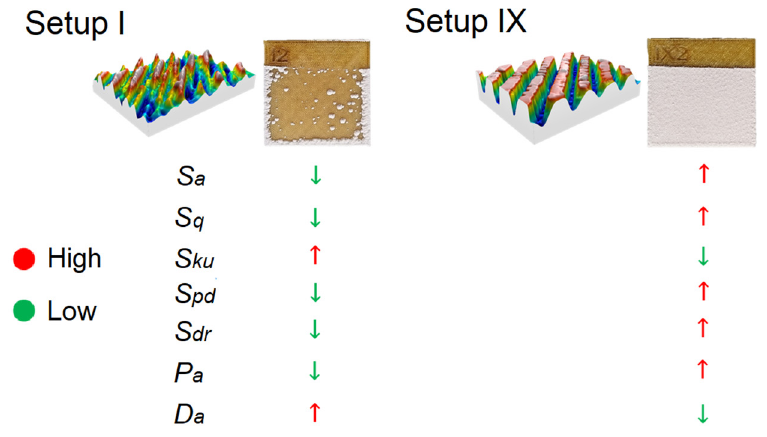
Figure 7. As-built surfaces and APS surfaces for setup I ( left ) and setup IX ( right ).